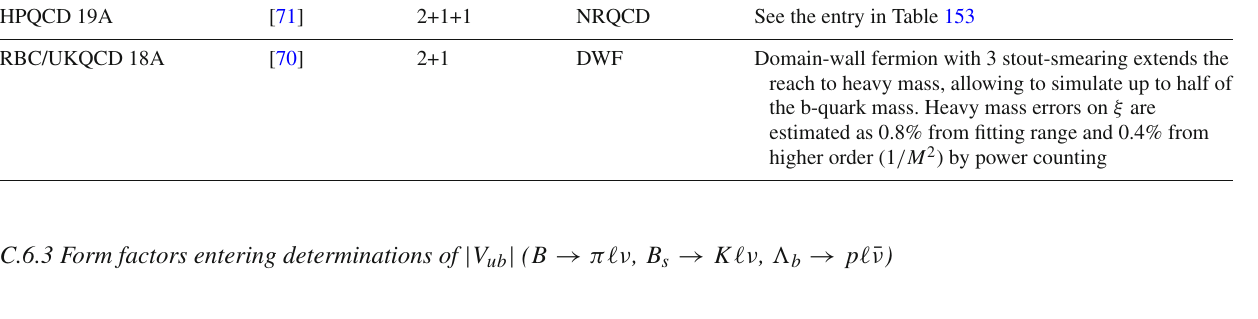
Table 155 Continuum extrapolations/estimation of lattice artifacts in determinations of B → π(cid:6)ν , B s → K (cid:6)ν , and (cid:8) b → p (cid:6) ¯ ν form factors Collab.